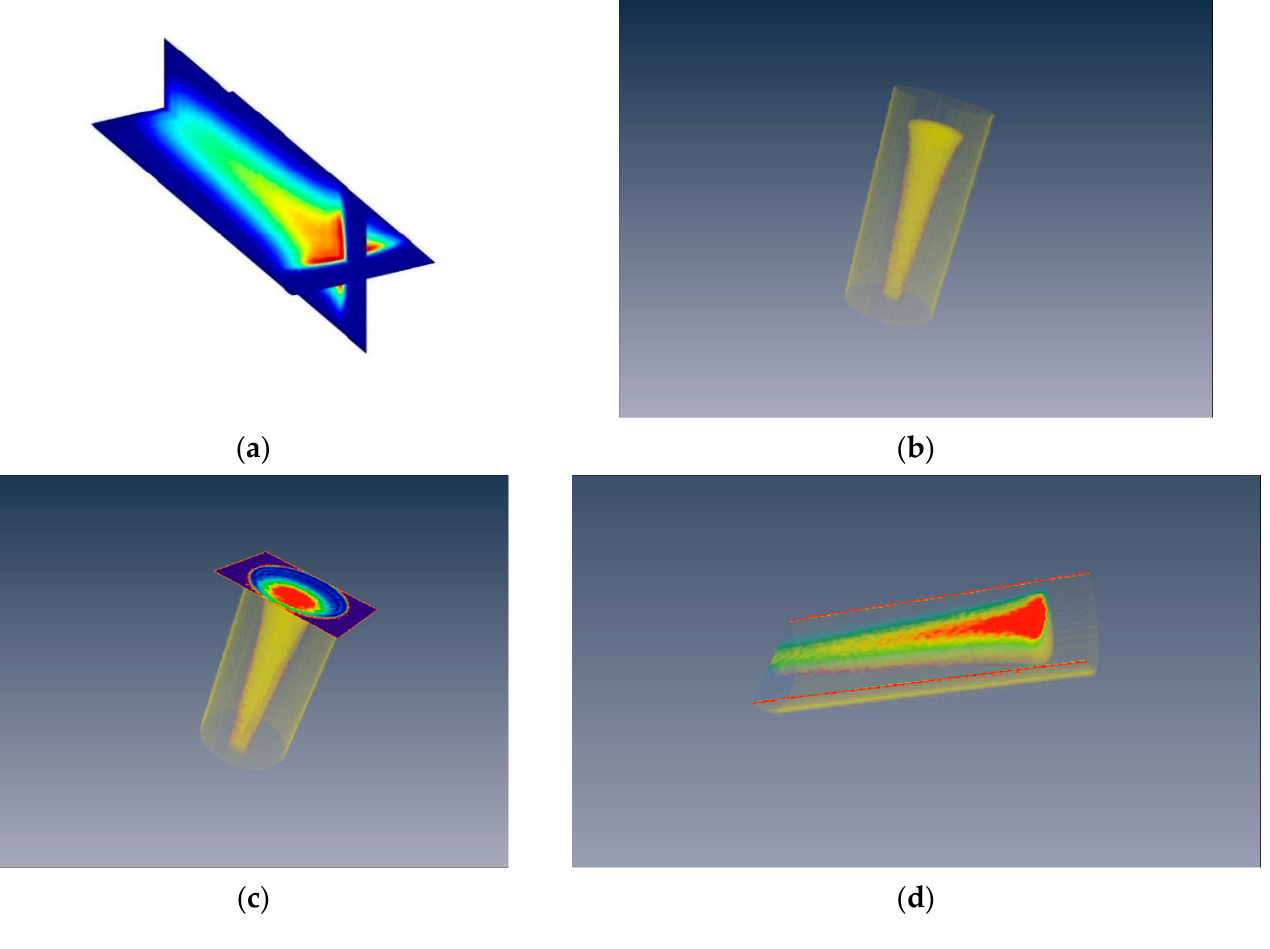
Figure 4. ( a ) Two crossed planes of the Bragg peak; ( b ) reconstructed 3D volume rendering of the Bragg peak; ( c ) transversal cut; and ( d ) longitudinal cut of the Bragg peak.